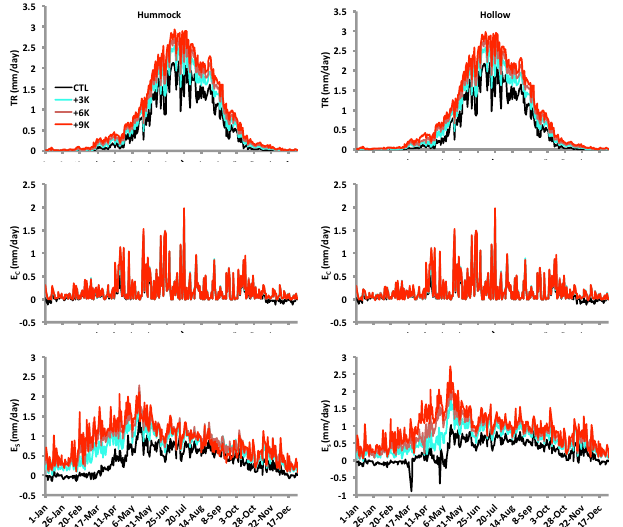
Figure 7. Seasonal dynamics (averaged over the 2011–2013 period) of three components of evapotranspiration, for control and 3 warm- ing scenarios under the constant Q assumption for humidity. TR, E c and E s are canopy transpiration, canopy evaporation and soil evaporation, respectively.